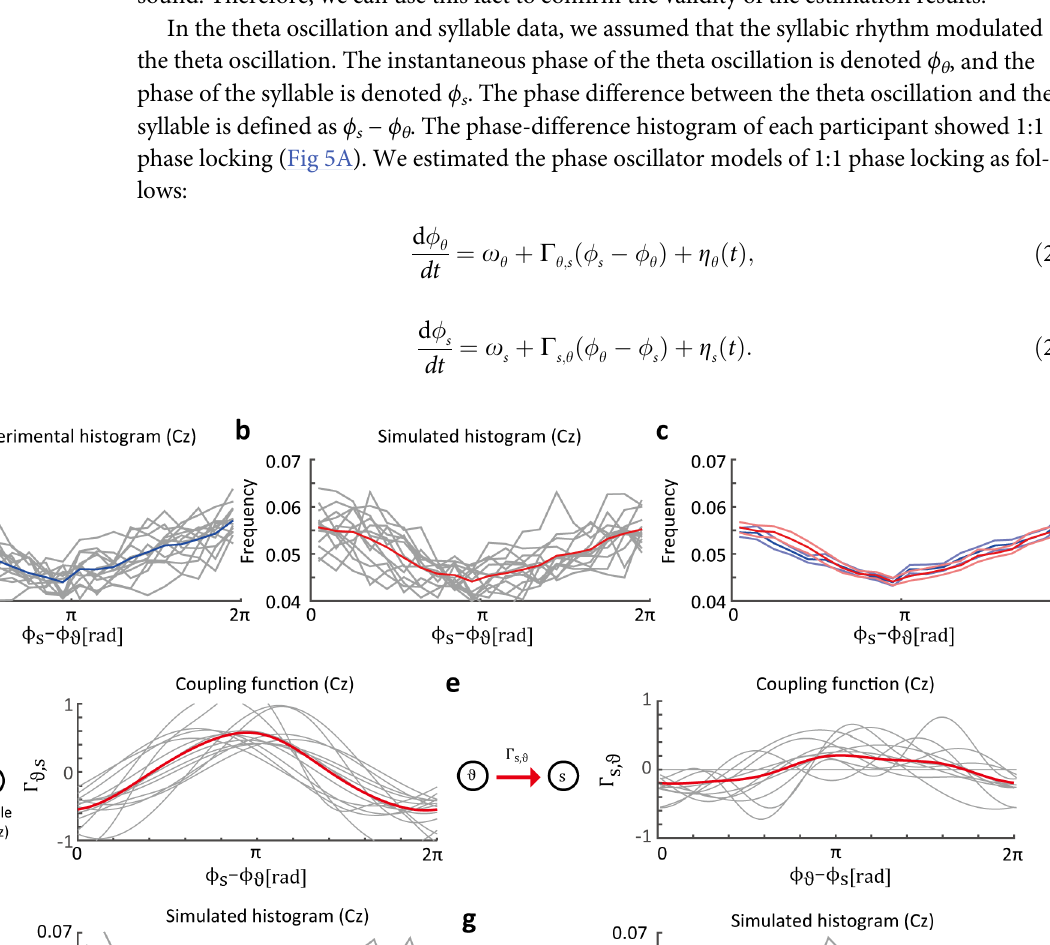
from syllabic θ , s were removed are nearly flat. θ , s